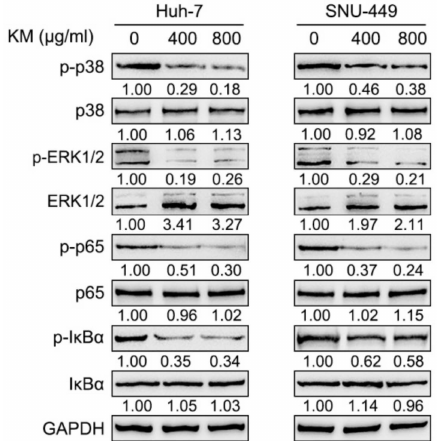
Figure 3. Koumine inhibits NF- κ B and ERK / p38 MAPK signaling pathways in HCC cells. HCC cells were treated with 0, 400, and 800 µ g / mL koumine and examined for the protein levels of p-ERK, ERK, p-p38, p38, p-p65, p65, p-I κ B α , and I κ B α